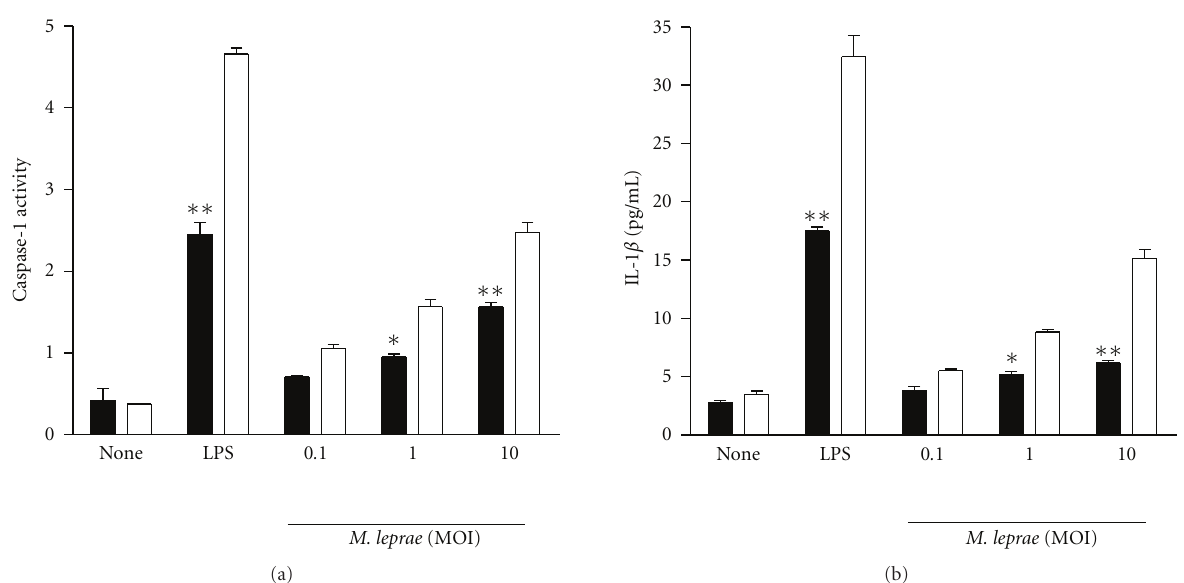
Figure 2: Caspase-1 activity and IL-1 β production in response to M. leprae infection in macrophages from A/J and C57BL/6 mice. Macrophages (10 6 ) from C57BL/6 and A/J mice were treated with LPS (100ng/ml) and M. leprae (MOI of 0.1, 1.0, and 10.0) for 18 h, and supernatants and cell lysates were assayed for IL-1 β concentrations and for caspase-1 activity, respectively. Open bar and closed bar represent macrophages from C57BL/6 and A/J mice, respectively. Data are representative of at least three independent experiments, each performed in triplicate. ∗ P < . 05; ∗∗ P < . 01.